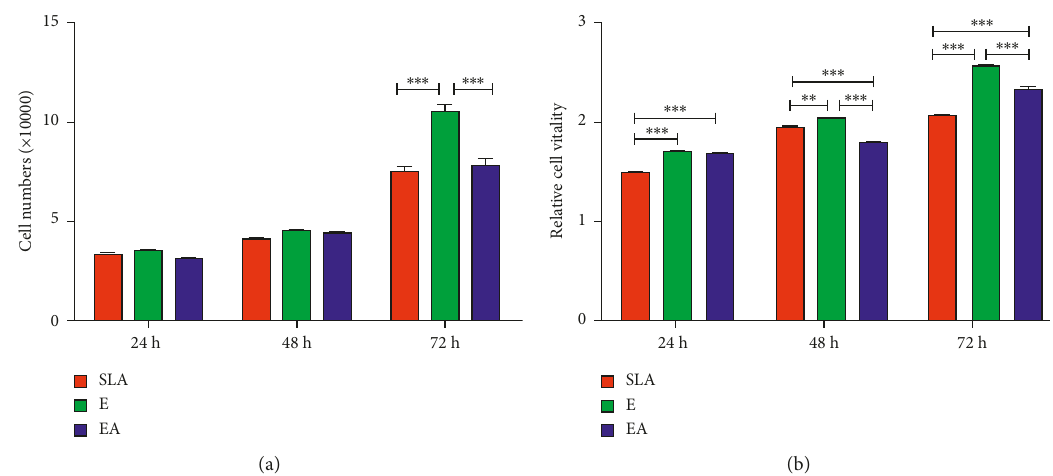
Figure 6: Cell numbers after culturing for 24, 48, and 72h (a) and cell viability after culturing for 24, 48, and 72h (b) ( ∗ P < 0 . 05; ∗∗ P < 0 . 01; ∗∗∗ P < 0 . 001).